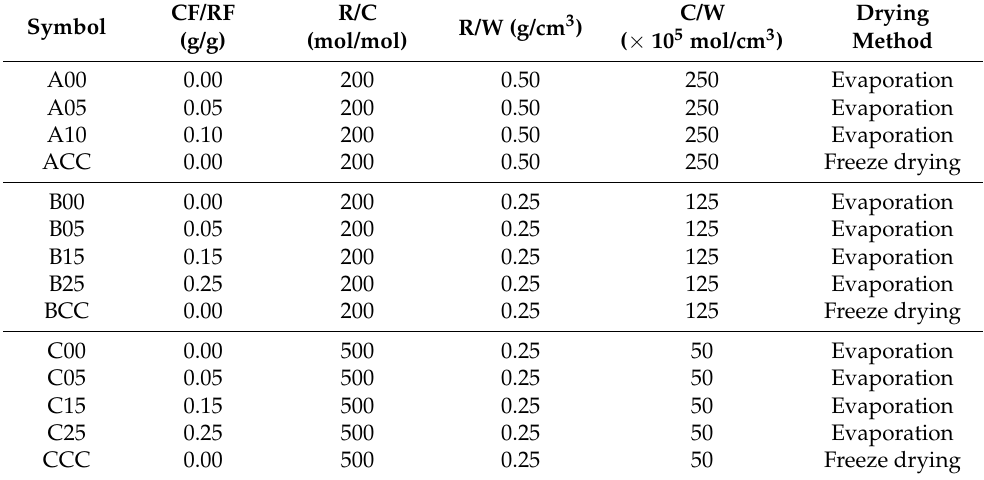
Table 1. Nomenclatures of C/C composite cryogels prepared under various synthesis